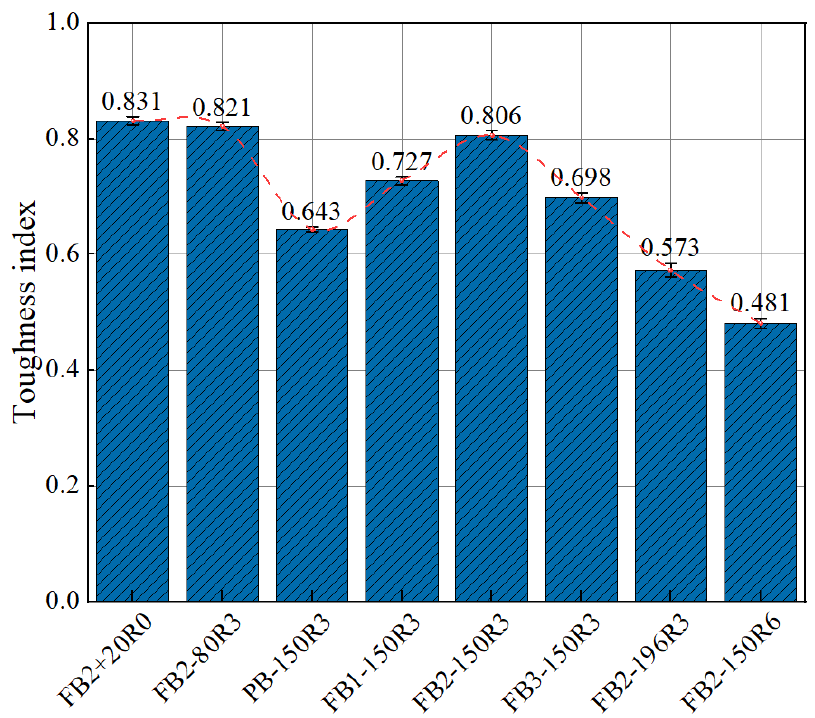
Figure 14. Statistics of BFRC toughness index under the influence of different factors. The toughness index of BFRC showed accelerated decay as the temperature gradient of the ultra-low-temperature cycles increased. Compared with the toughness index of specimens experiencing freeze–thaw cycles from 20 ◦ C to − 80 ◦ C, the toughness index of specimens experiencing freeze–thaw cycles from 20 ◦ C to − 150 ◦ C and − 196 ◦ C decreased by 1.83% and 30.21%, respectively. This indicates that the appropriate amount of